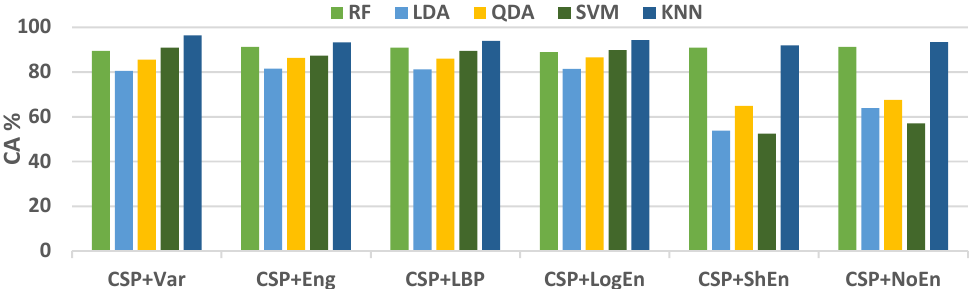
Figure 5. Average classification accuracy (off–PD vs. HC) using FR, LDA, QDA, SVM, and KNN.